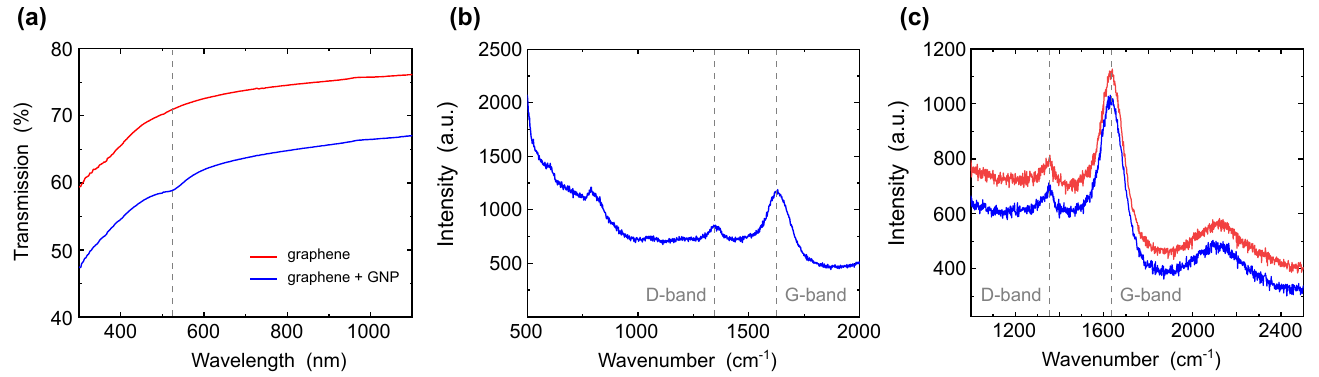
Figure 4. ( a ) UV-VIS spectra of graphene (red curve) and graphene with gold nanoparticles (blue curve). ( b ) Raman spectra of graphene with gold nanoparticles. ( c ) Raman spectra of graphene of two different samples.